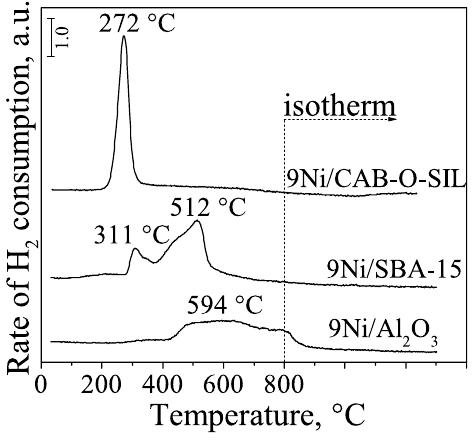
-TPR of NiO particles supported on alumina and silicas. Figure 9 : H 2